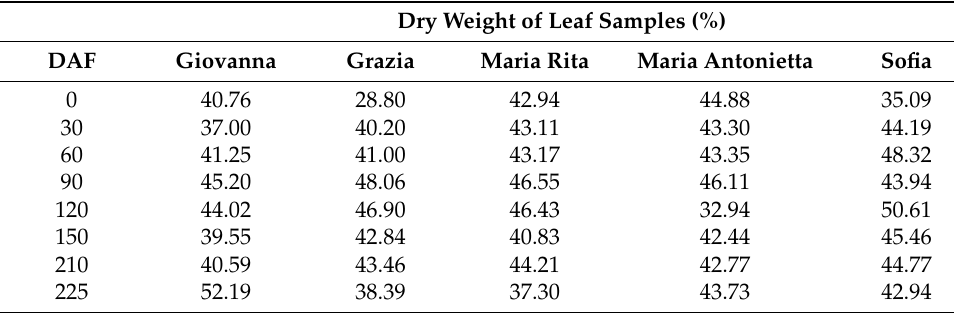
Table 3. Dry weight expressed in percentage of myrtle leaf extracts.